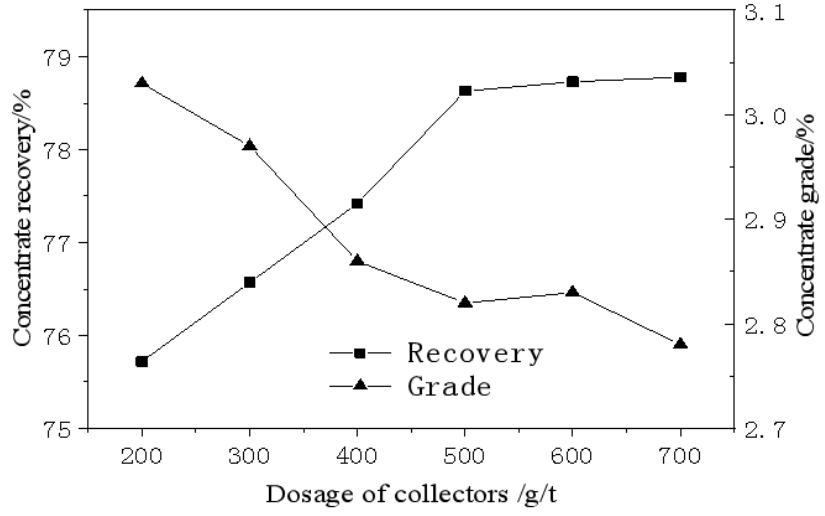
Figure 4. Influences of the collecting agent dosage of the copper oxide flotation index.